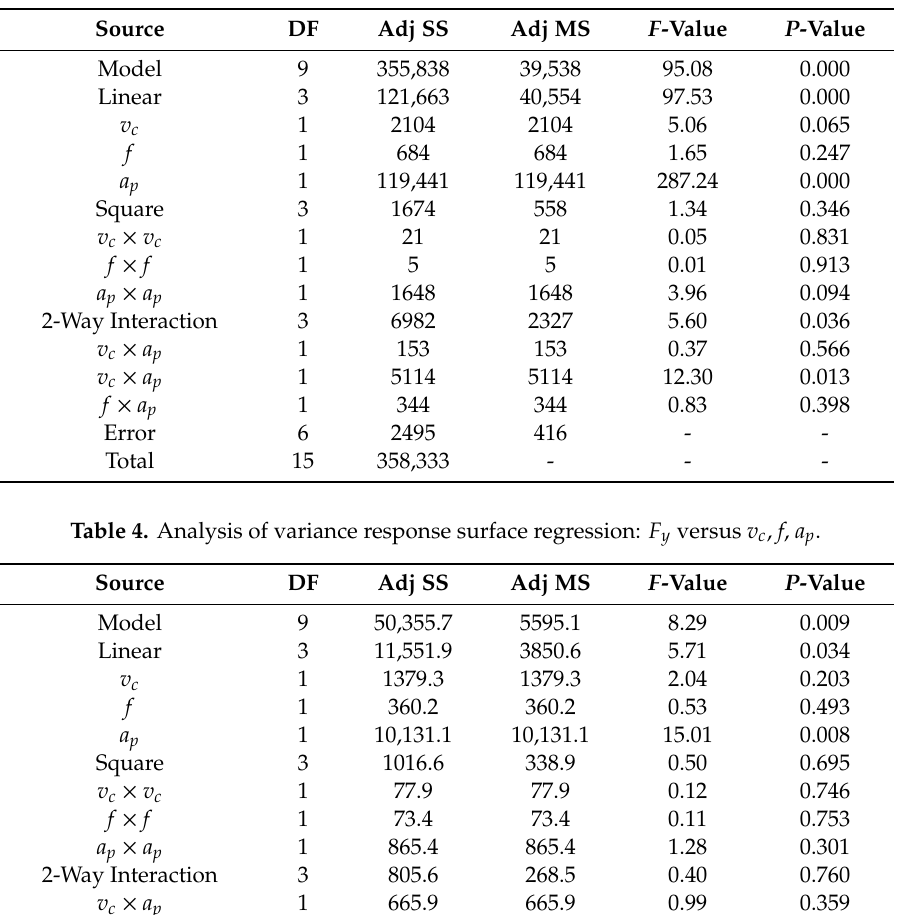
Table 3. Analysis of variance of response surface regression: F x versus v c , f , a p .